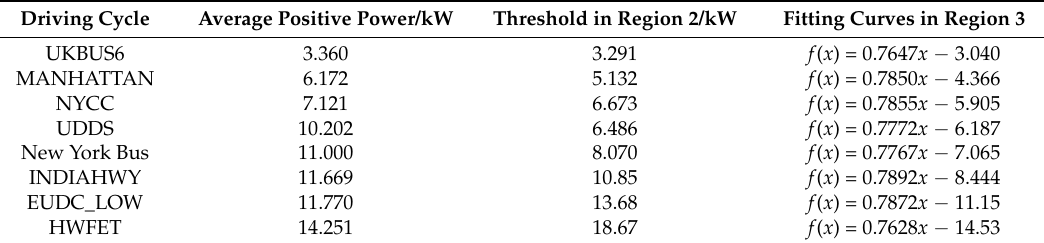
Table 3. Data statistics of each driving